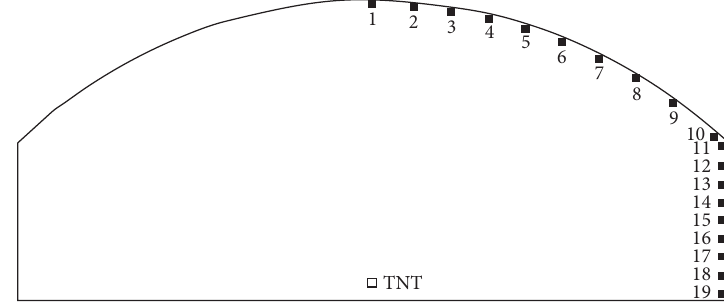
Figure 4: Schematic diagram of the unit positions. Table 2: Peak overpressure values at each unit